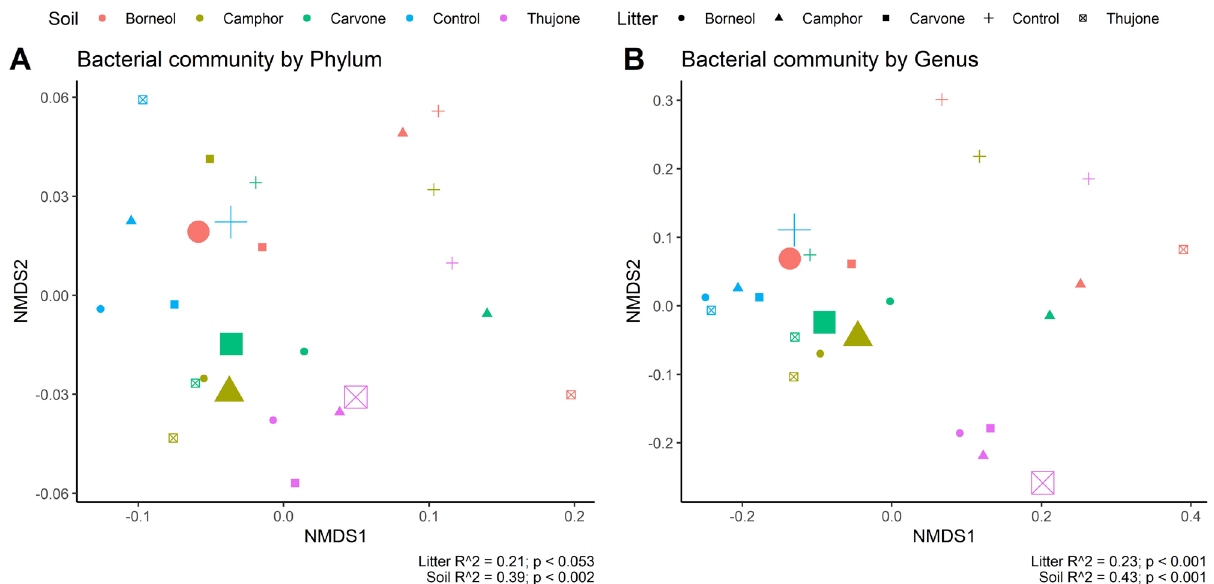
Figure 4. Soil and bacterial community interaction at the Phylum ( A ) and at the Genus ( B ) level. Non-Metric Multidimensional Scaling (NMDS) using microbial sequencing data were applied to reveal relational patterns among bacterial phyla and genera and tansy chemotype. The large points show where soil and litter came from the same chemotype or control